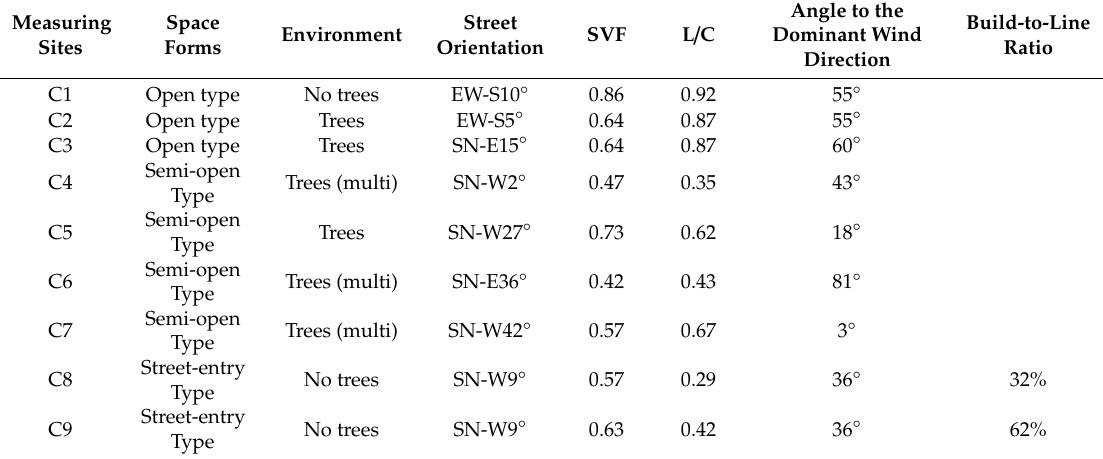
Table 4. Spatial features of the measuring sites.